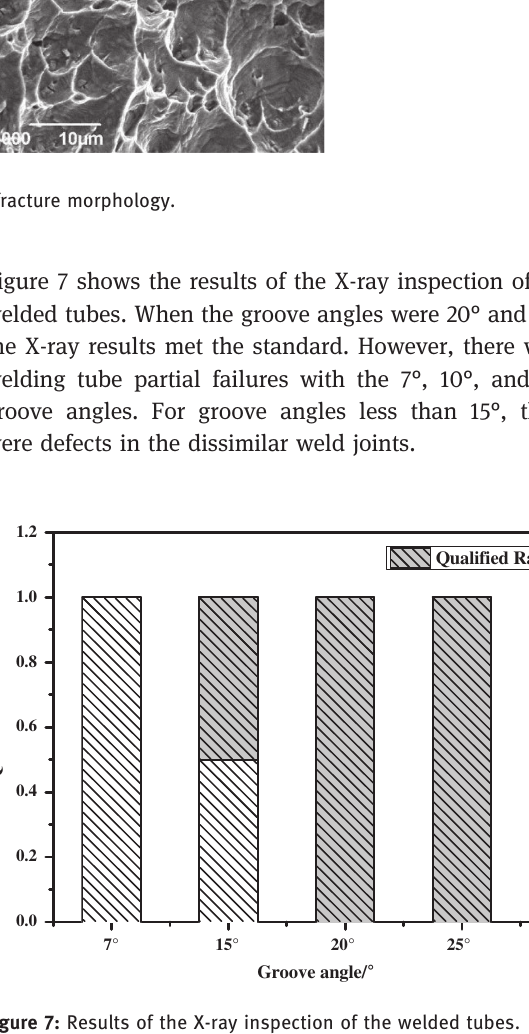
Figure 7: Results of the X-ray inspection of the welded